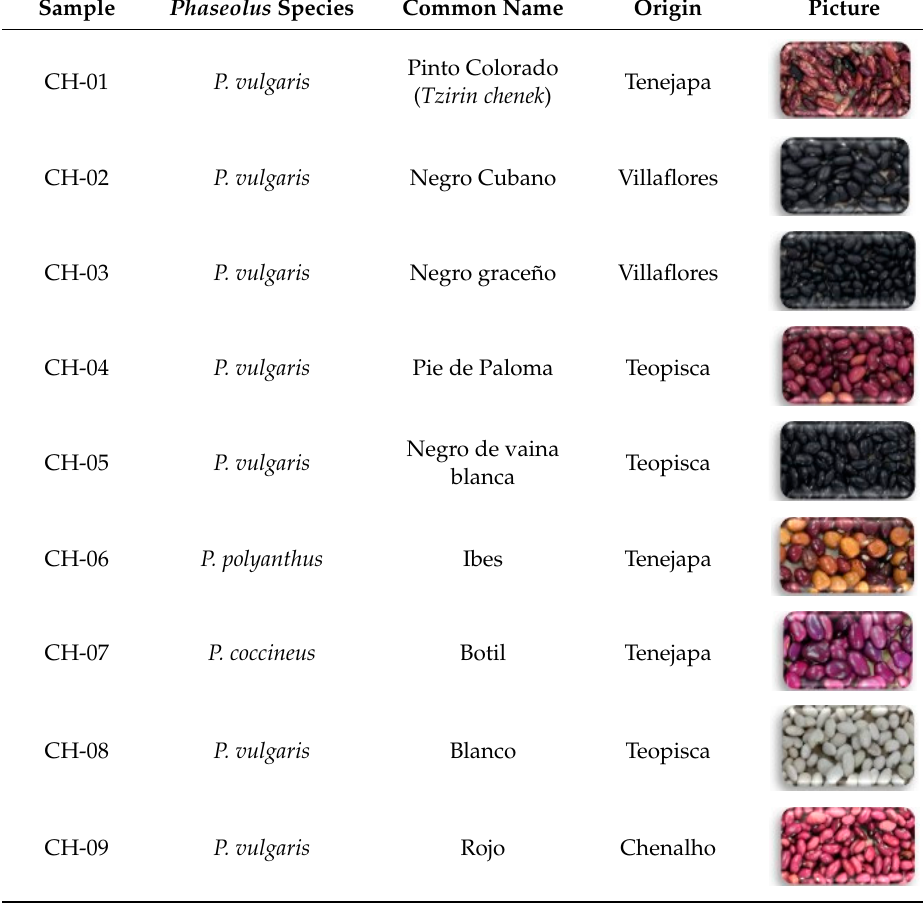
Table 5. Phaseolus species of beans collected in the Mayan region (Mexico).